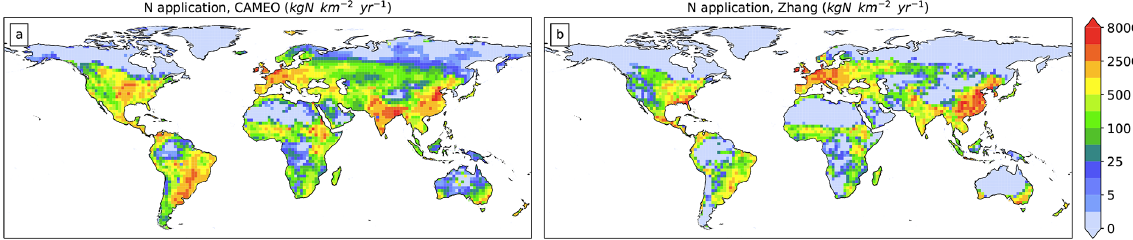
Figure 2. The manure application (kgNkm − 2 yr − 1 ) (a) simulated by CAMEO and averaged over the 2005–2015 period and (b) calculated by Zhang et al. (2017a) for 2006.